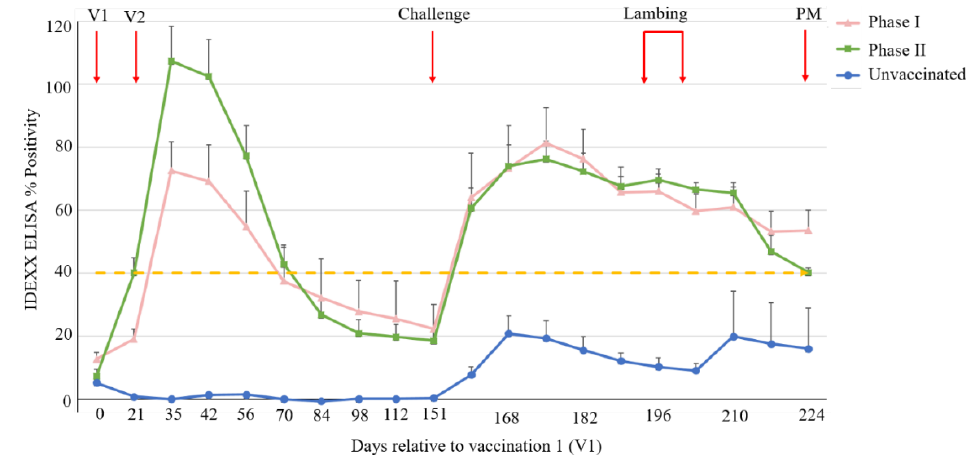
Figure 2. Serological ELISA responses following vaccination and C. burnetii challenge. Each point represents the average of each group, with standard error of mean (SEM) displayed. Each group is represented by a unique symbol and colour combination. Ovine sera were considered C. burnetii positive if the percentage positivity was ≥ 40% (dashed yellow line). V1 and V2 = vaccination 1 and 2, respectively; Challenge = C. burnetii challenge; PM = post-mortem.